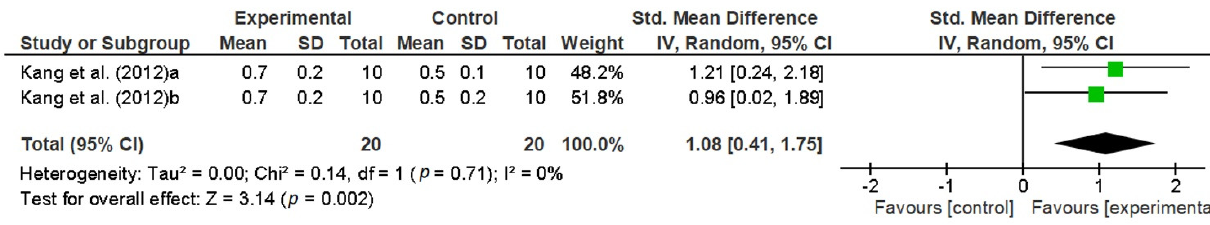
Figure 6. Pooled standardized mean differences and overall effect size (95% CI) on 10MWT immediately after the intervention in Kang et al.’s study. (a) VR treadmill with optic flow versus control group. (b) VR treadmill with optic flow group versus treadmill group.